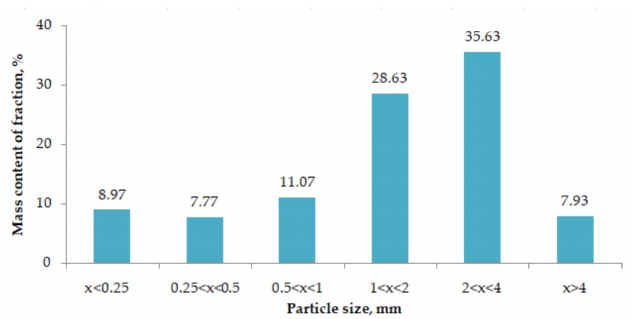
Figure 3. Grain size distribution of shredded post-harvest tobacco